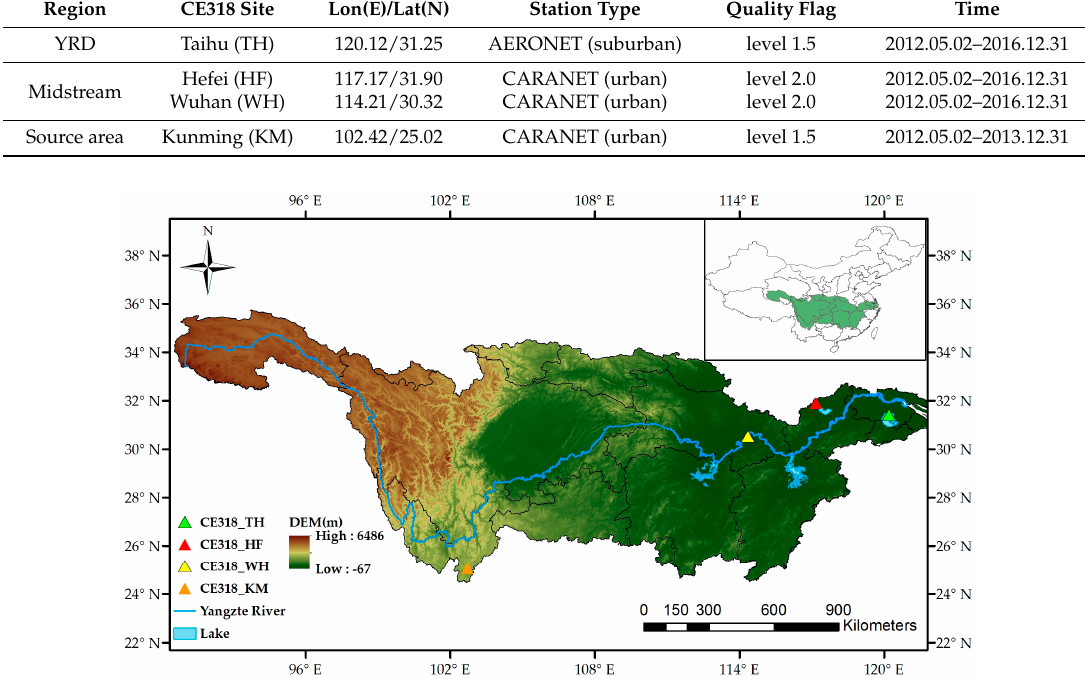
Figure 1. The location of the aerosol ground sites (triangle symbol) over YRB.